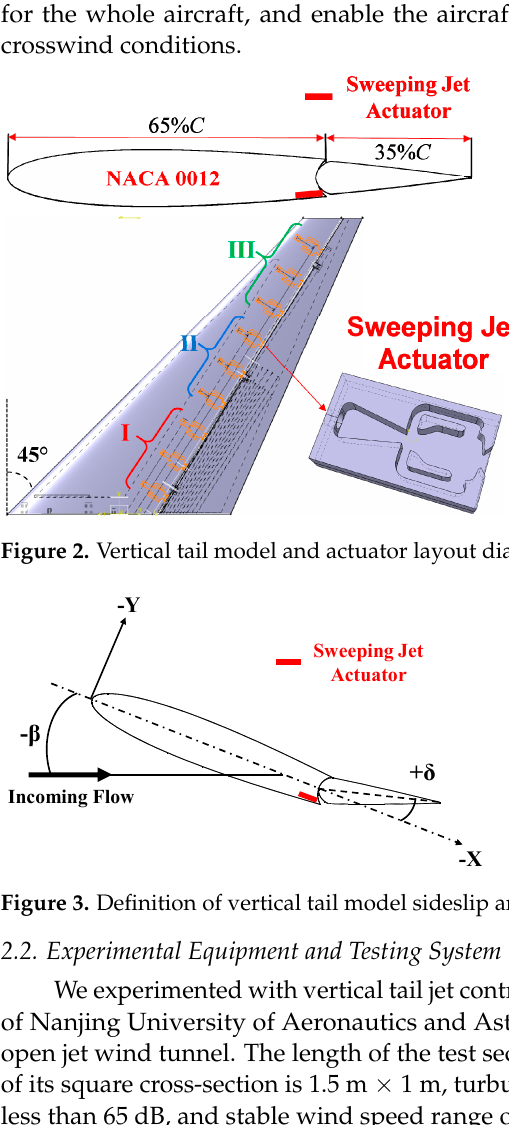
Figure 2. Vertical tail model and actuator layout diagram.